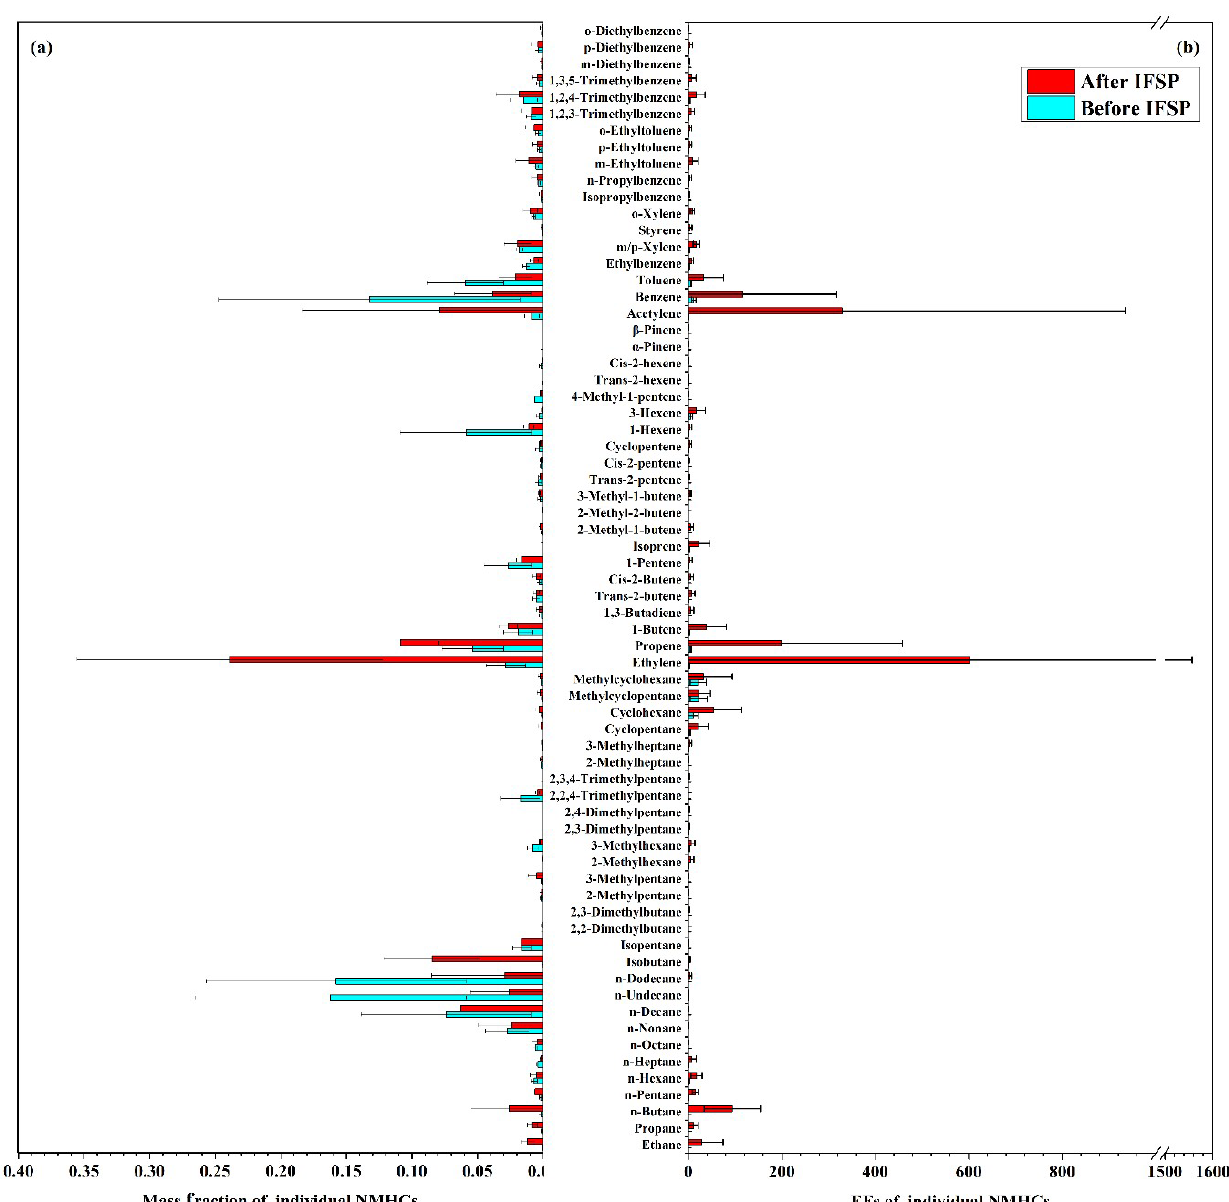
Figure 4. Comparison of VOCs emission factors before and after IFSP for coastal